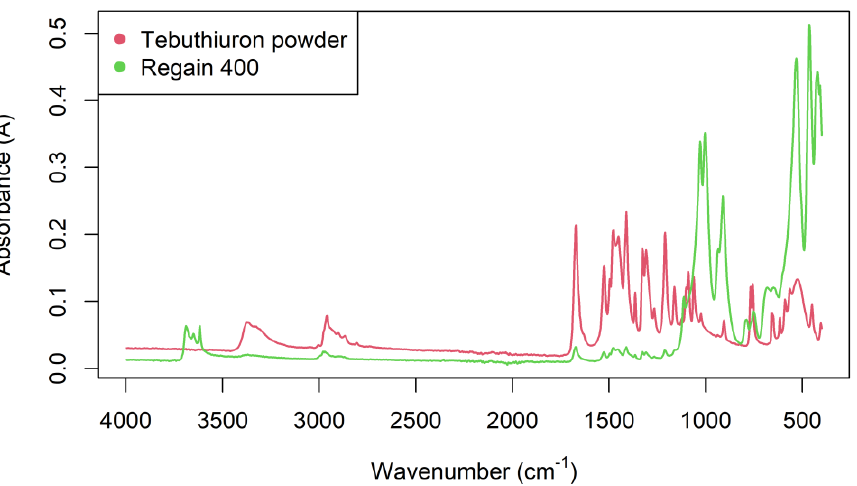
Figure 8. FTIR spectra of a typical powdered 400 mg/g Regain sample and a sample of pure tebuthiuron powder (99.6% purity). Table 5. The major peaks observed in the FTIR spectrum of pure tebuthiuron powder and their assigned bonds.